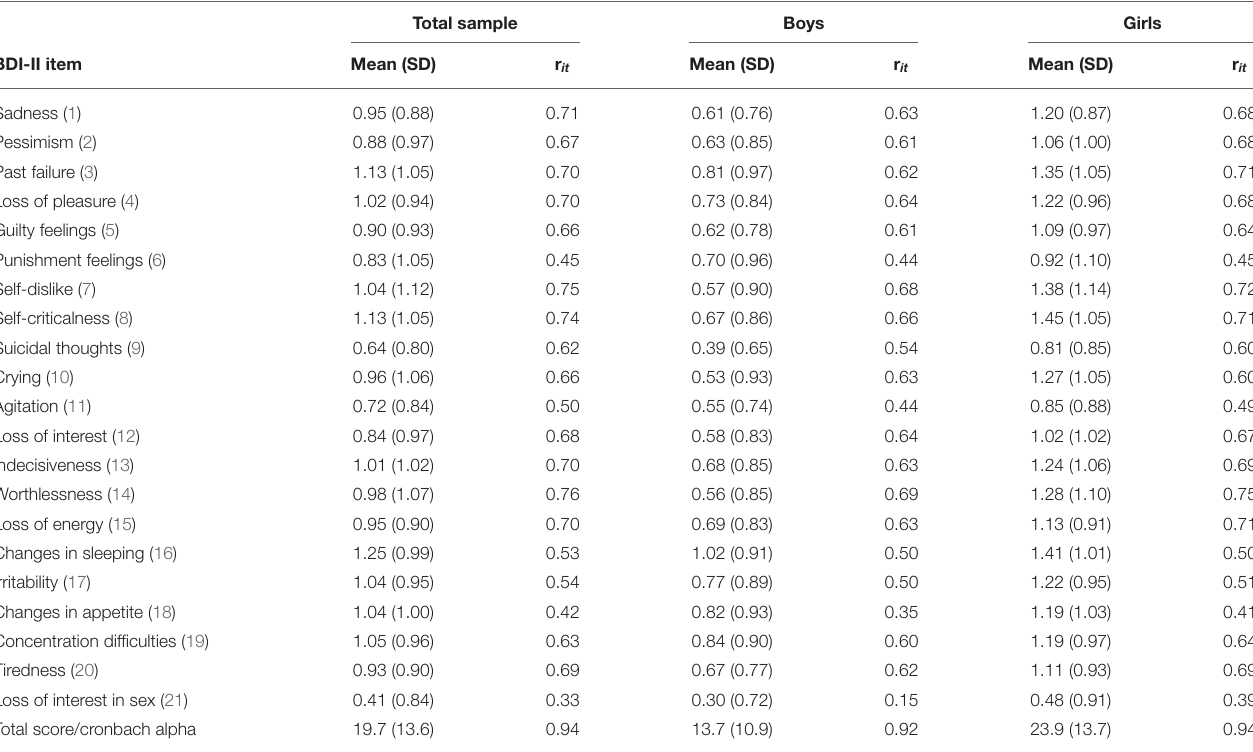
TABLE 1 | Means, standard deviations (SD) and item-total correlations (r it ) for the BDI-II items in the total sample ( n = 835) and for boys ( n = 345) and girls ( n = 490). Total sample Boys Girls